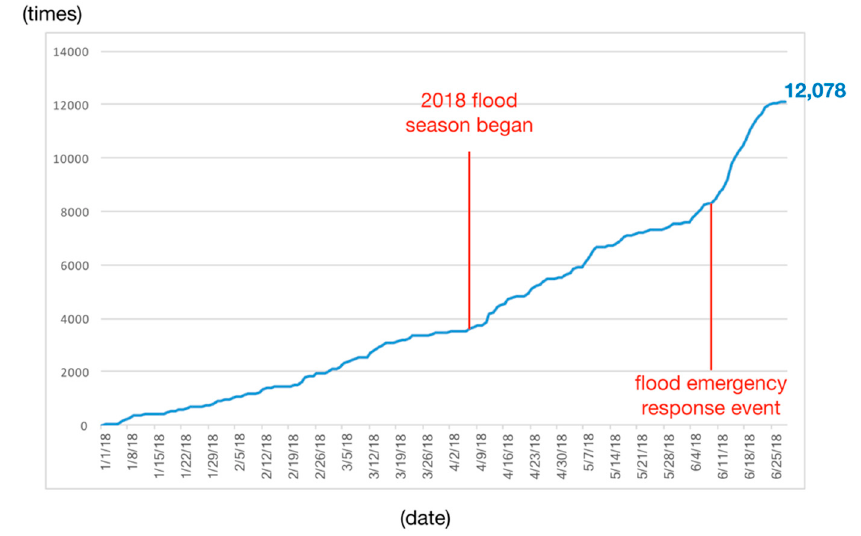
Figure 9. The cumulative usage graph of Ask Diana.